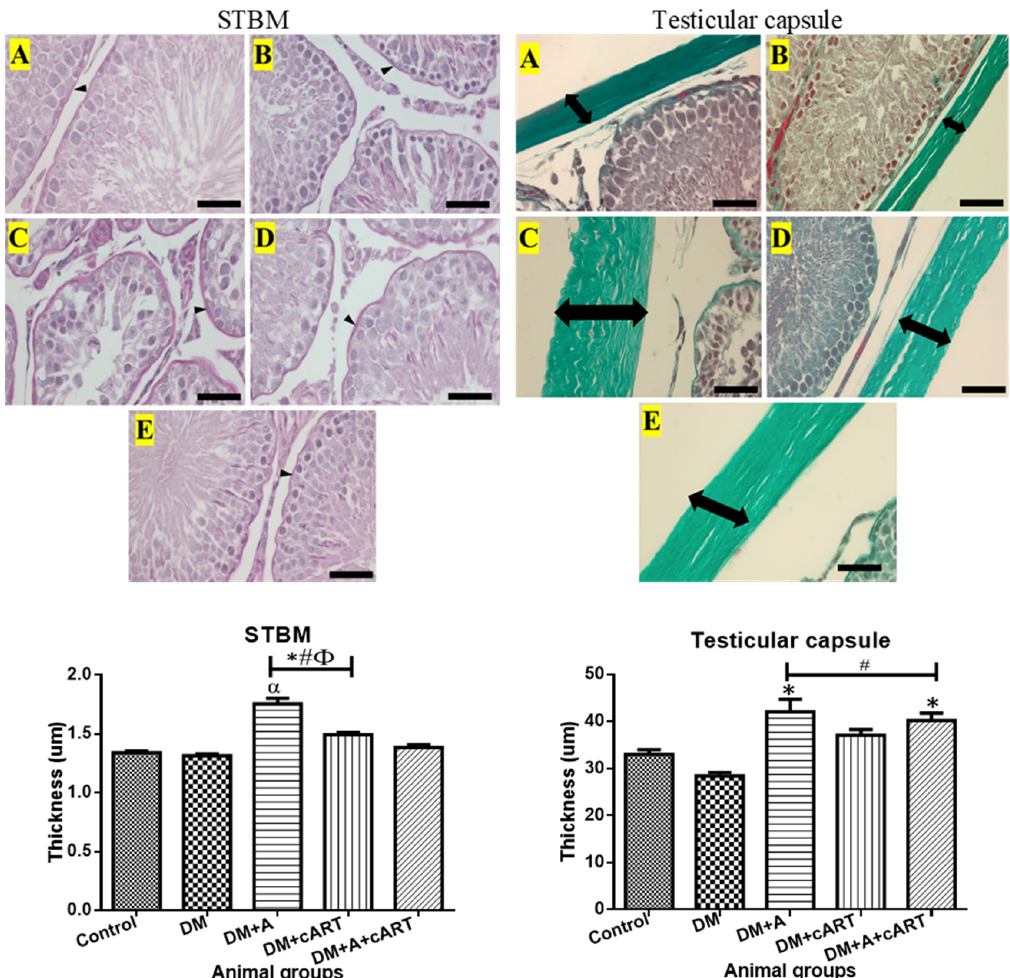
Figure 3. Representative seminiferous tubule basement membrane (STBM) (arrowheads) and testicu- lar capsule (double arrows) photomicrographs, PAS, and Masson’s trichrome stain. The graphs